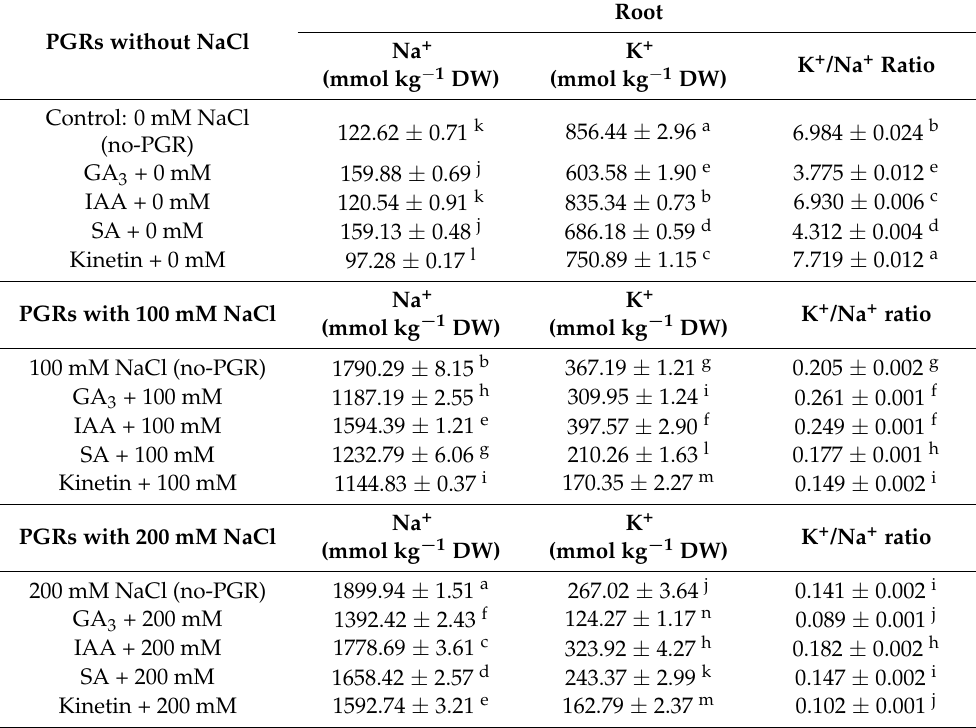
Table 3. Effect of salt stress on Na + and K + concentrations, and K + /Na + ratio in root of Olea europaea plants pretreated with plant growth regulators (PGRs). Data are expressed as mean ± SE (n=4).